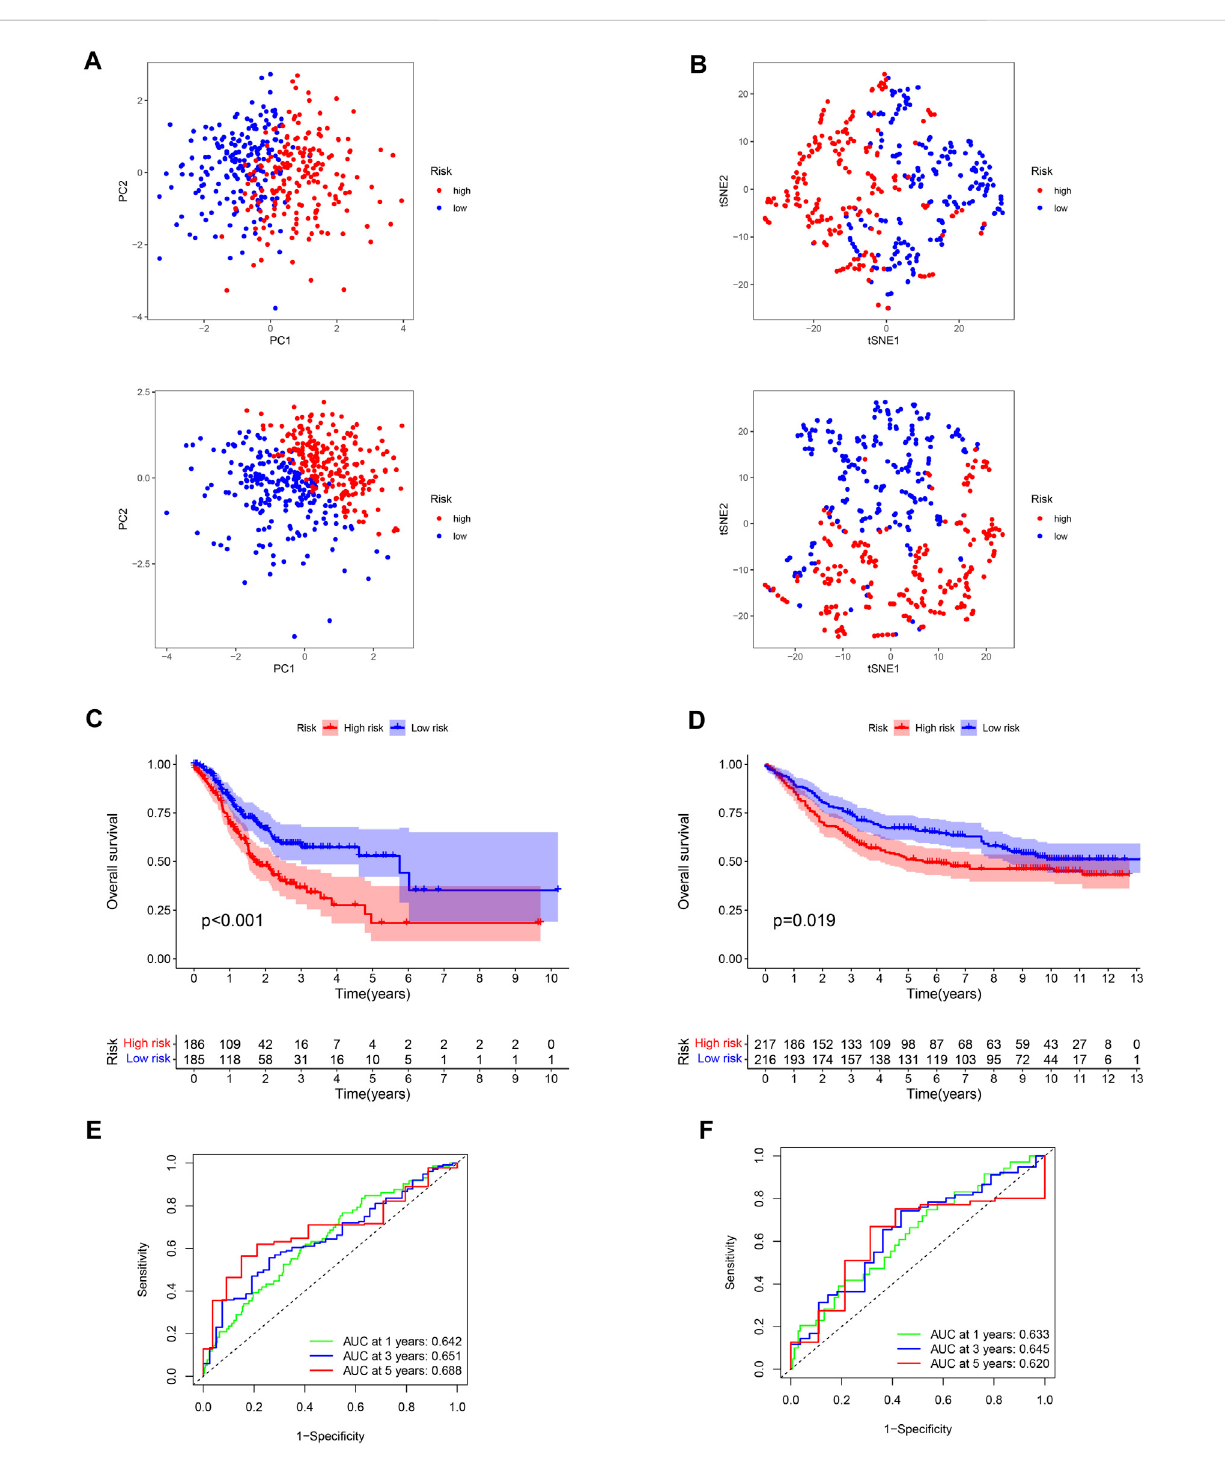
FIGURE 5 Veri fi cation of the stability of ROS-related signature. (A) PCA analysis of low- and high-risk GC for TCGA-STAD and GSE84437 datasets. (B) t-SNE analysis for TCGA-STAD and GSE84437 datasets. (C) K-M curve for different risk GC in TCGA-STAD dataset. (D) K-M curve for patients in GSE84437 dataset. (E) ROC analysis of the ROS-related signature across TCGA-STAD project. (F) ROC analysis of ROS-related signature across GSE84437